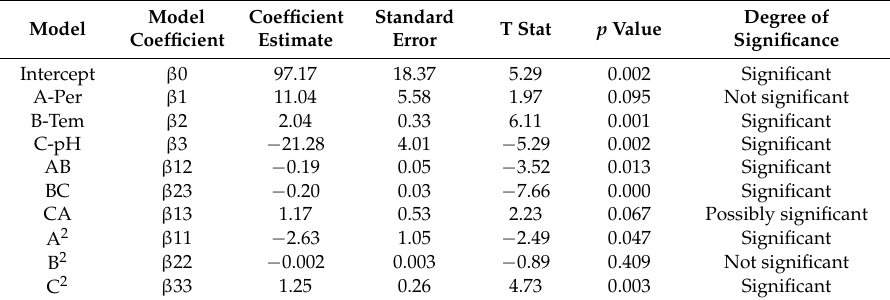
Table 5. p -test significance of model terms in the quadratic polynomial model.